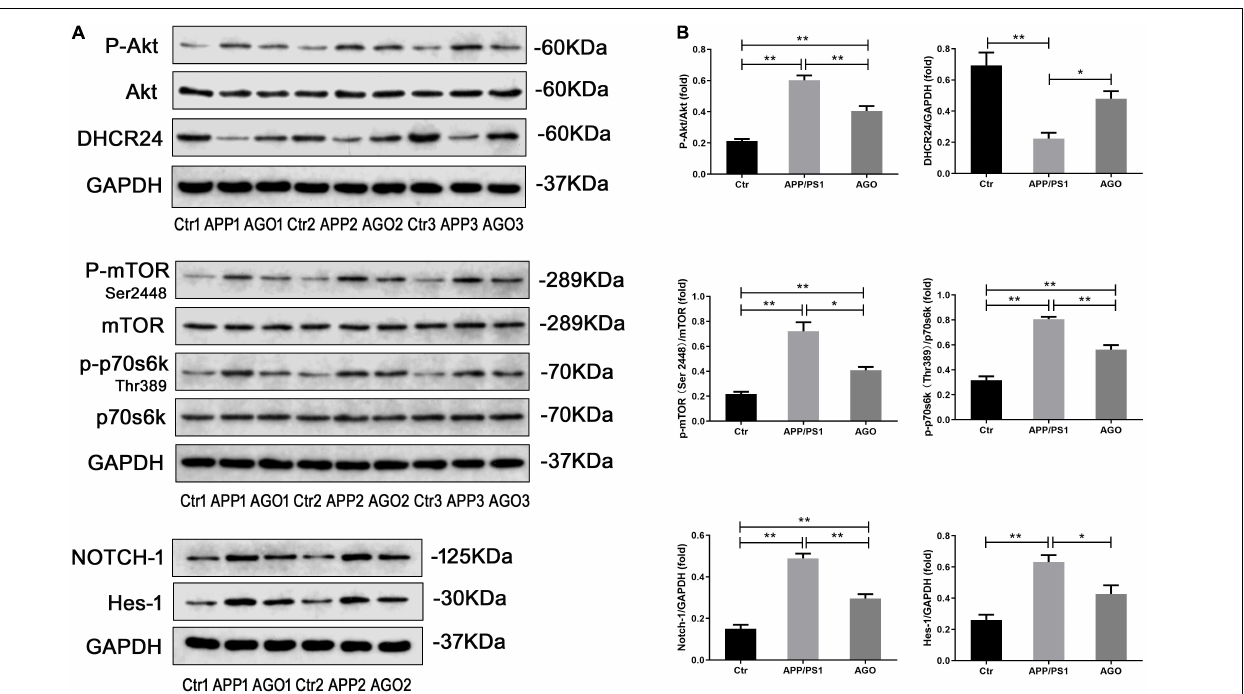
FIGURE 5 | The neuroprotective mechanism of agomelatine in APP/PS1 mice. In the agomelatine-treated group, mice were intraperitoneally injected with agomelatine (50 mg/kg/day) for 30 days. (A,B) Measurement of P-Akt, Akt, P-GSK3 β , GSK3 β , p-mTOR, mTOR, p-p70s6k, p70s6k, DHCR24, Hes-1, and Notch1 expression by Western blot ( n = 5). Values are represented as the mean ± SEM. * P < 0.05; ** P <